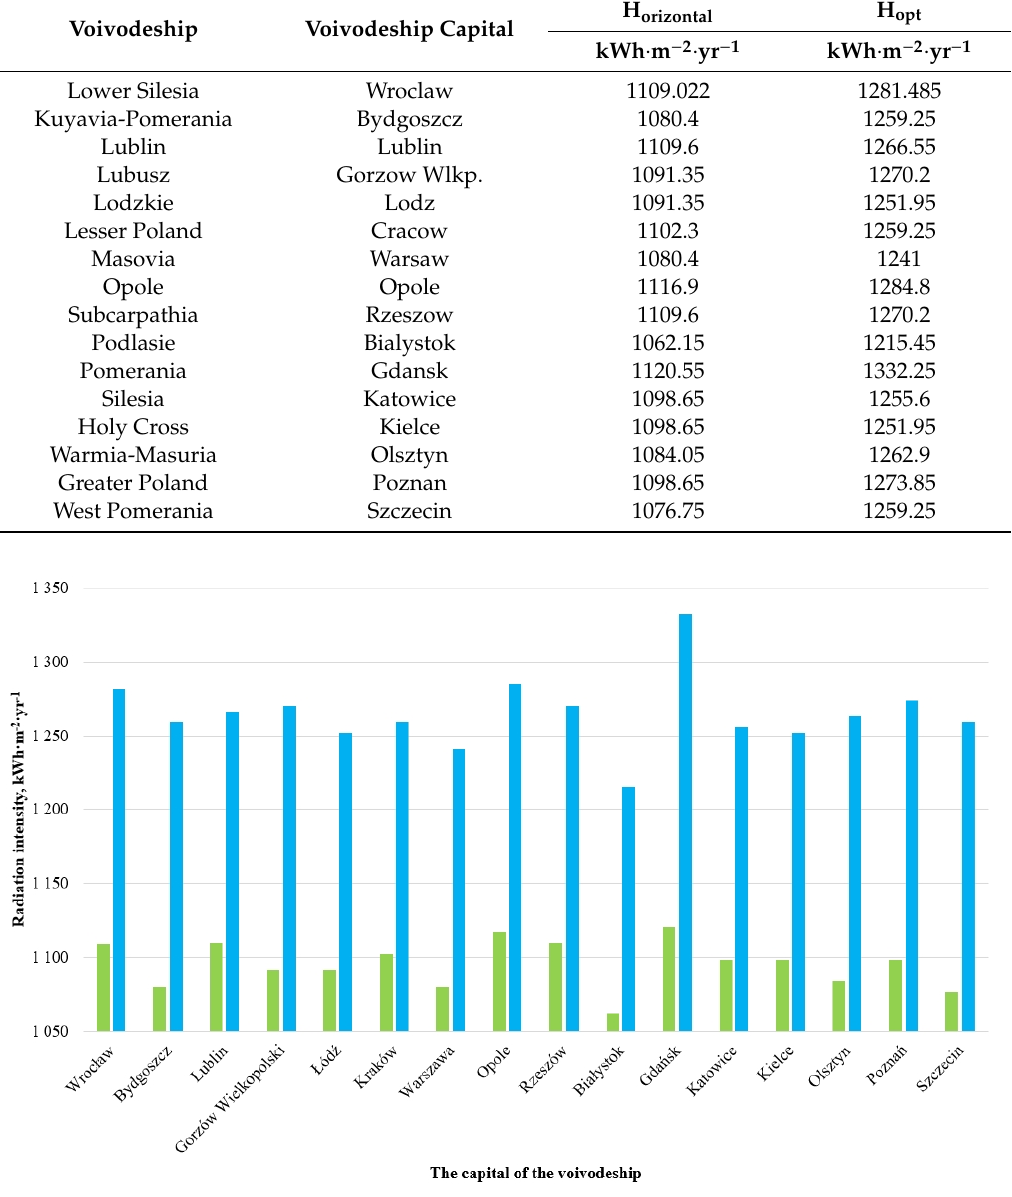
Table 2. The amount of energy reaching the horizontal surface and surface set at an optimal angle for individual voivodeship [47].